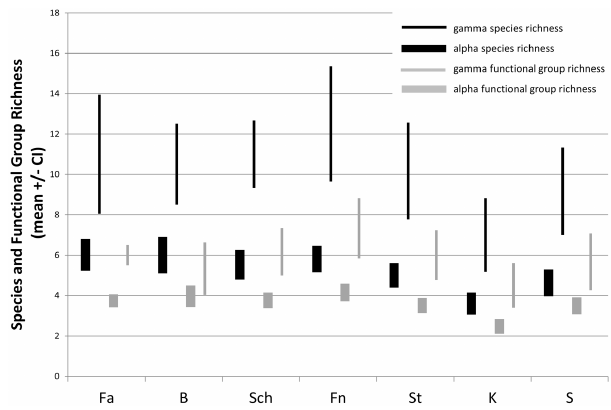
Fig. 5. Relation between species richness and functional group rich- ness at the level of panels. Functional group richness shows satu- ration at elevated taxonomic richness indicating functional redun- dancy in diverse communities. Note that single dots may represent several replicates and n = 277